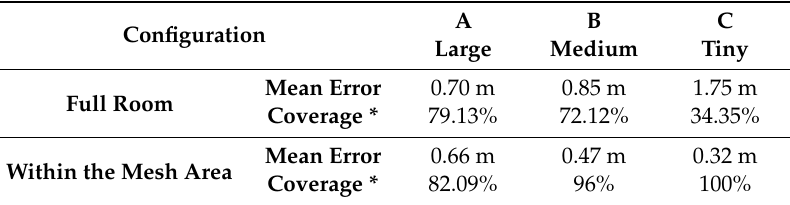
Table 3. Measured localization error